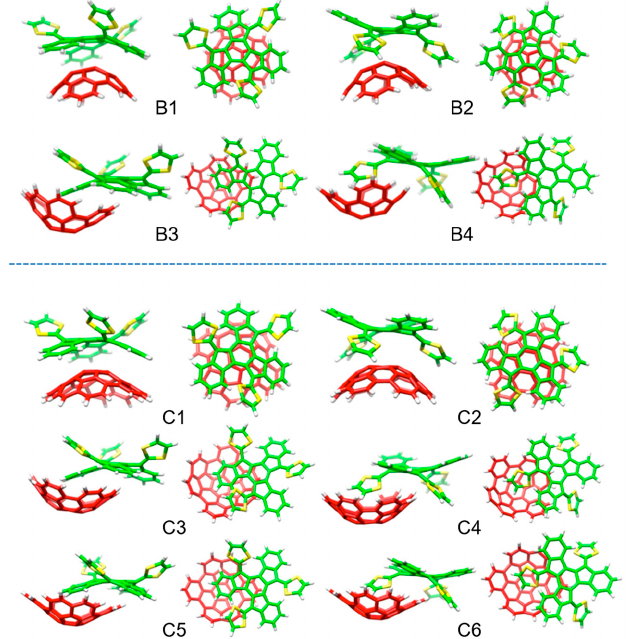
Figure 21. Minimum-energy structures and computed at the revPBE0-D3/cc-pVTZ level for the most stable conformations of the heterodimers formed by the C 32 H 12 ( B1 – 4 ) and C 38 H 14 ( C1 – 6 ) fullerene fragments with truxTTF (truxTT • C 32 H 12 and truxTT • C 38 H 14 ). Except for the carbon atoms of the C 32 H 12 and C 38 H 14 buckybowls depicted in red, the following color code is used: carbon in green, sulfur in yellow and hydrogen in white. Adapted with permission from Reference [19]. Copyright 2017 WILEY-VCH Verlag GmbH & Co. KGaA,